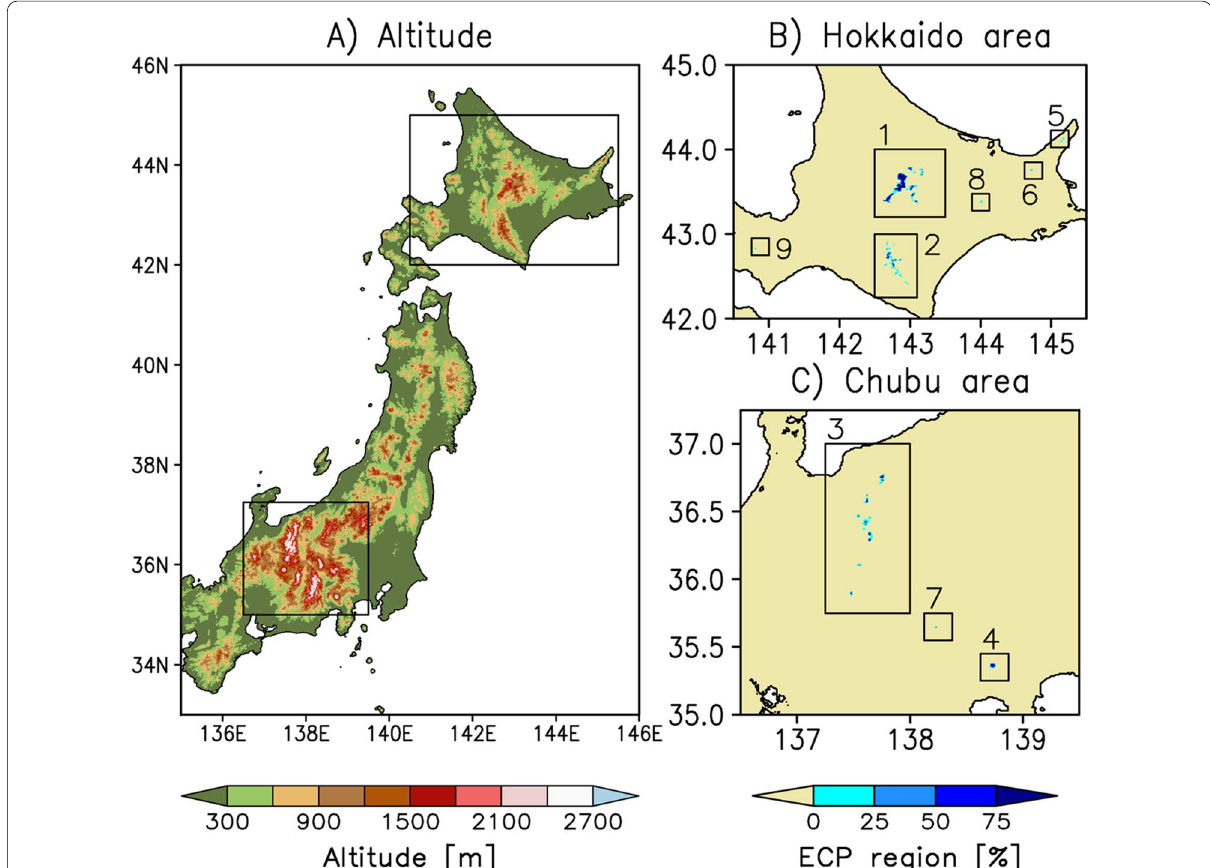
Fig. 1 a Map showing the altitude [m] of northern and eastern Japan, and the distribution of regions with surface air temperatures that favor the maintenance of permafrost (the Environmentally Conditioned Permafrost regions) in Japan; b Hokkaido and c the Chubu. The numbers indicate (1) Daisetsu Mountains, (2) Hidaka Mountains, (3) Northern Japan Alps, (4) Mt. Fuji, (5) Mt. Shiretokodake, (6) Mt. Shari, (7) Southern Japan Alps, (8) Mt. Akandake, and (9) Mt. Yotei. The distribution of the environmentally conditioned permafrost region is based on probabilities estimated by nine bias-corrected climate